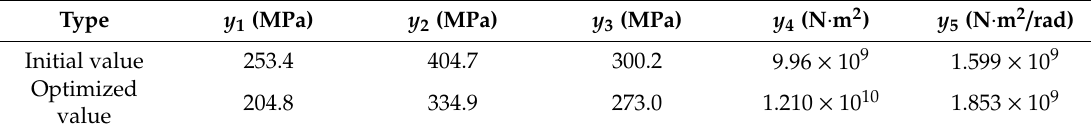
Table 10. Comparison of the initial and optimized certain objective